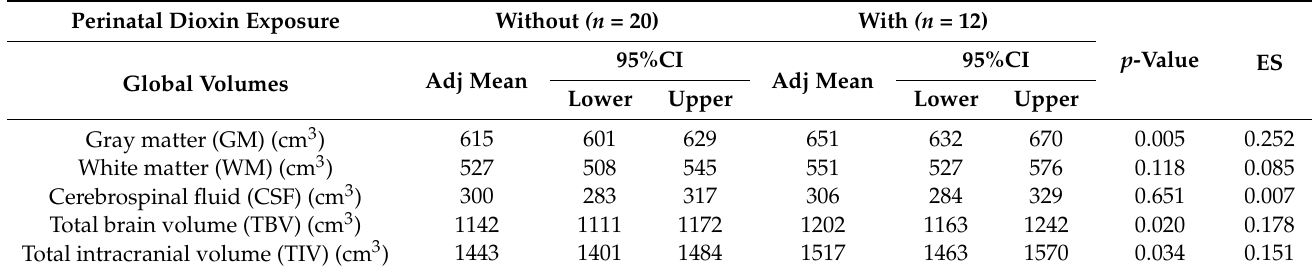
Table 4. Adjusted comparisons of global brain volumes between men with and without perinatal dioxin exposure estimated according to their mothers’ residency in Bien Hoa during